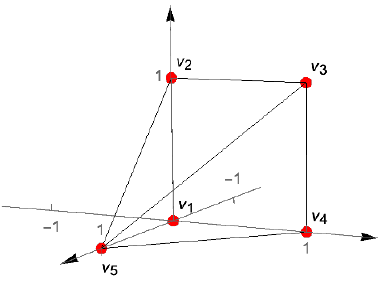
Figure 3 . Toric diagram for the link of the C (cid:2) Conifold